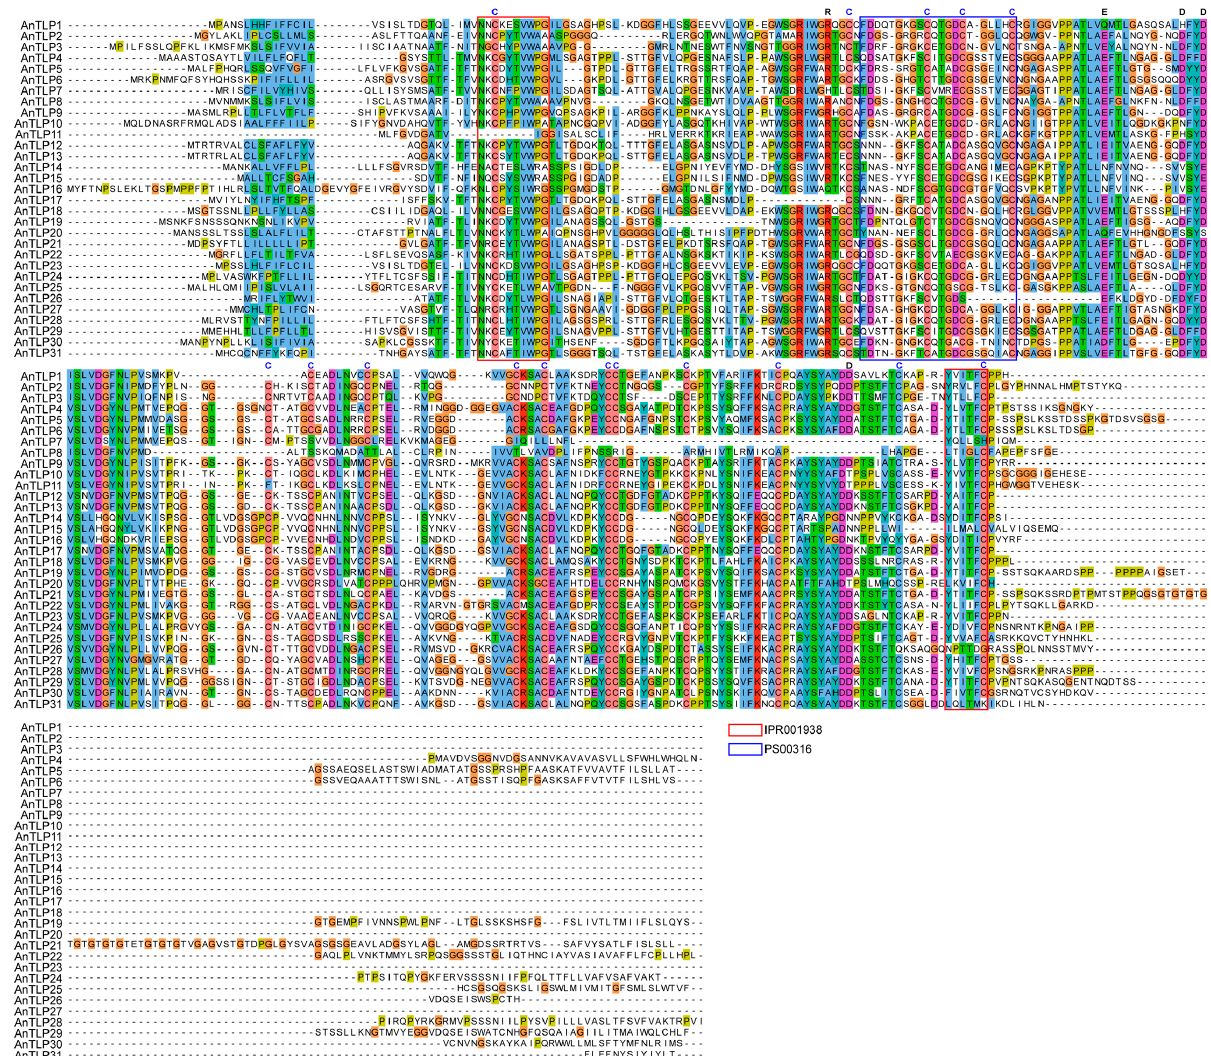
Figure 2. Multiple sequence alignment of TLPs in A. nanus . Jalview software was used to visualize the results of multiple sequence alignment, and the color scheme was selected as ‘Clustal’. Conservative domain was used by box (iPR001938, red box; PS00316, blue box). The amino acids in the REDDD motif are highlighted in black letters. The conserved cysteines are highlighted in blue